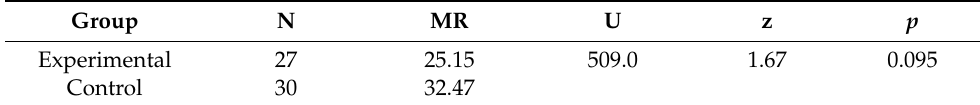
Table 4. Results of the Mann-Whitney U test of the scores for TFQs and MCQs. Group